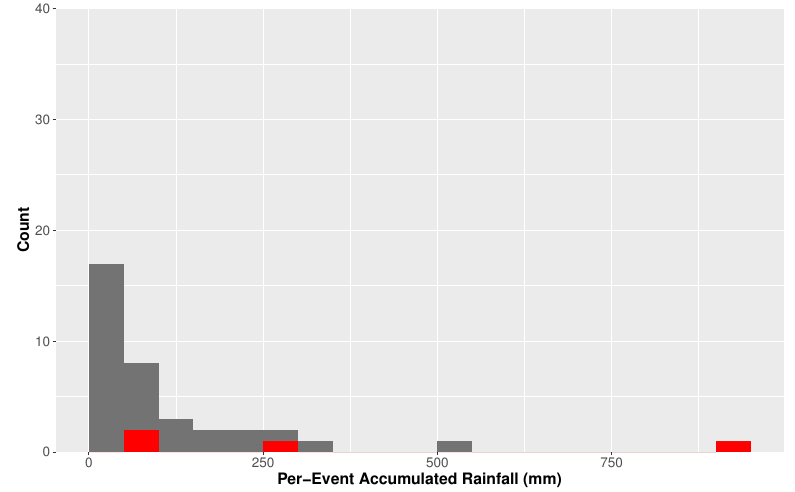
Figure 3. Histogram for tropical cyclone rainfall for Houston, Texas. Red bars indicate events post 2007.